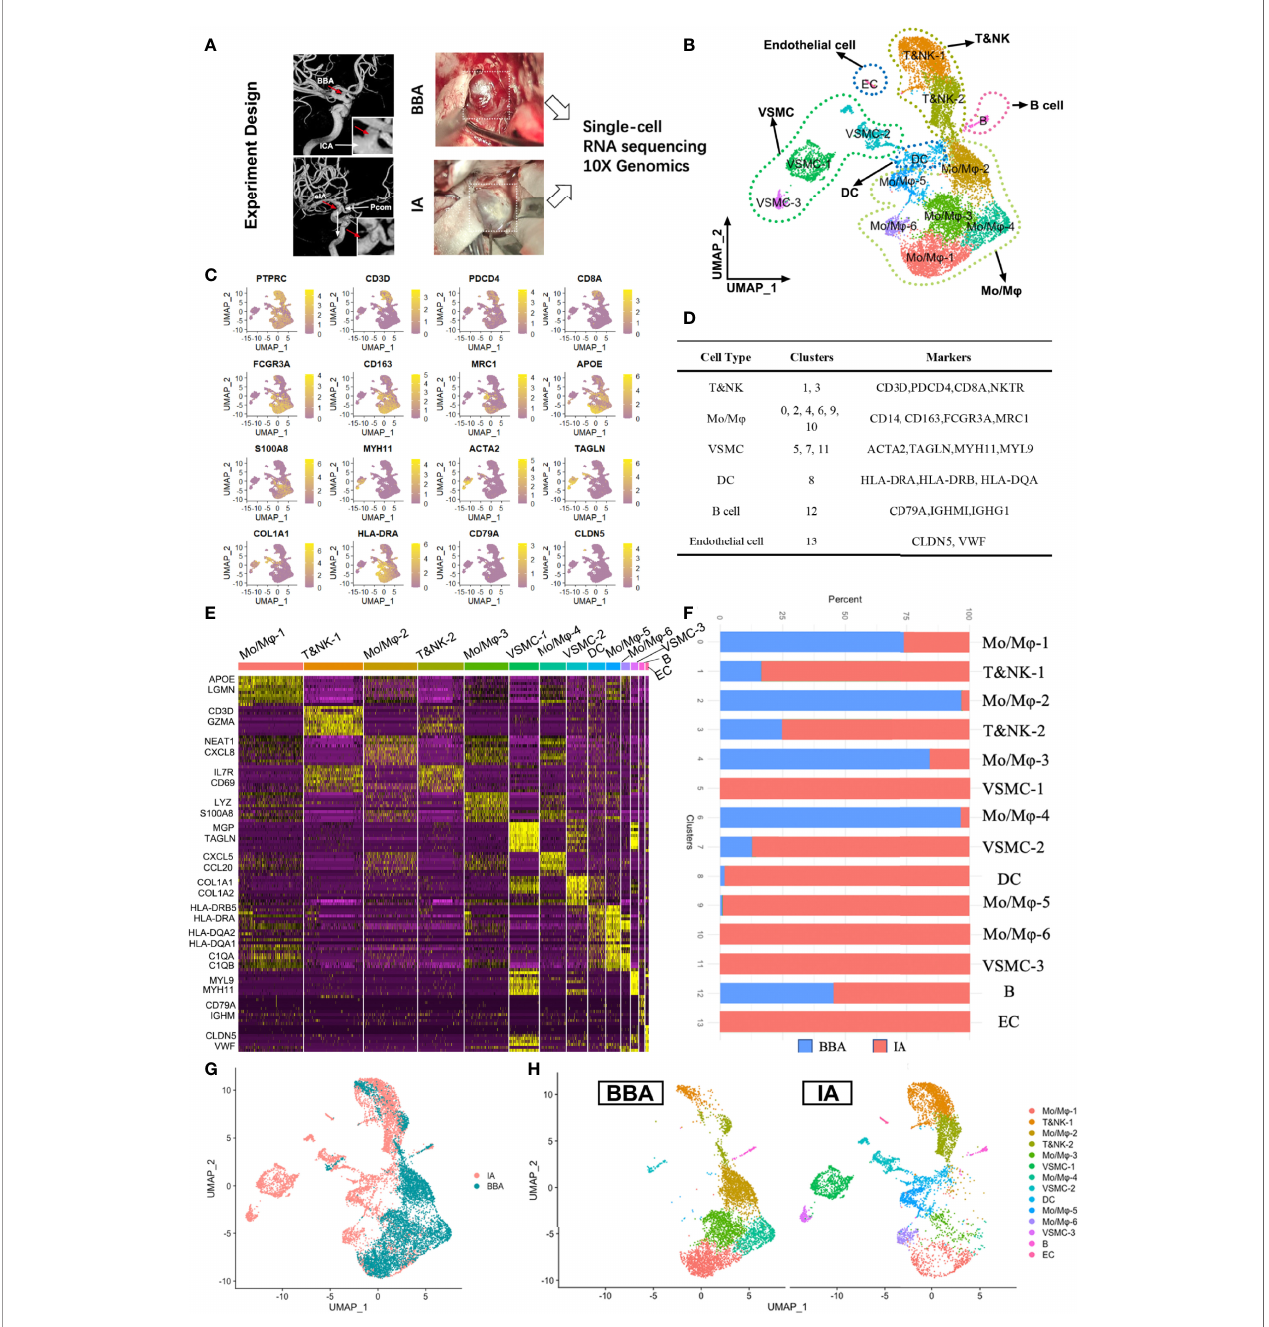
FIGURE 1 | Single-cell RNA sequencing of 2 saccular intracranial aneurysms (IA) and a blood blister-like aneurysm (BBA). (A) Experiment design of scRNA-seq. (B) Seurat clustering of all cells in aneurysms. (C) Featured genes used for classi fi cation. (D) Major cell types and subclusters of cells. (E) Heat map showing the gene enrichment of different clusters. (F) Different distributions of cells in BBA and IA. (G, H) Distinct distribution of cell clusters in cell